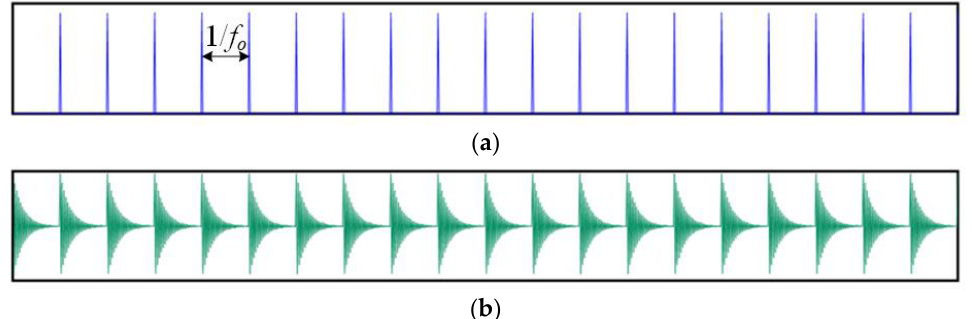
Figure 6. OF Excitation signal and response signal. ( a ) The excitation signal of OF; ( b ) The response signal of OF impact.